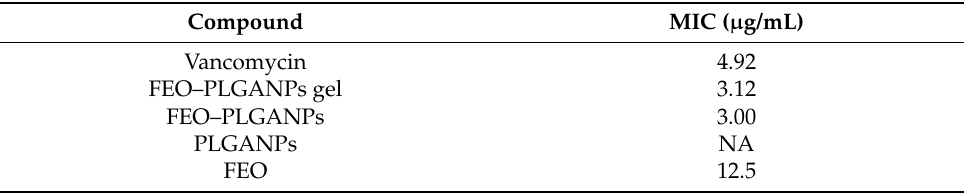
Table 2. Comparative in vitro antibacterial activity of FEO–PLGANPs gel, FEO–PLGANPs, PLGANPs and FEO against S. aureus (MTCC 10787)